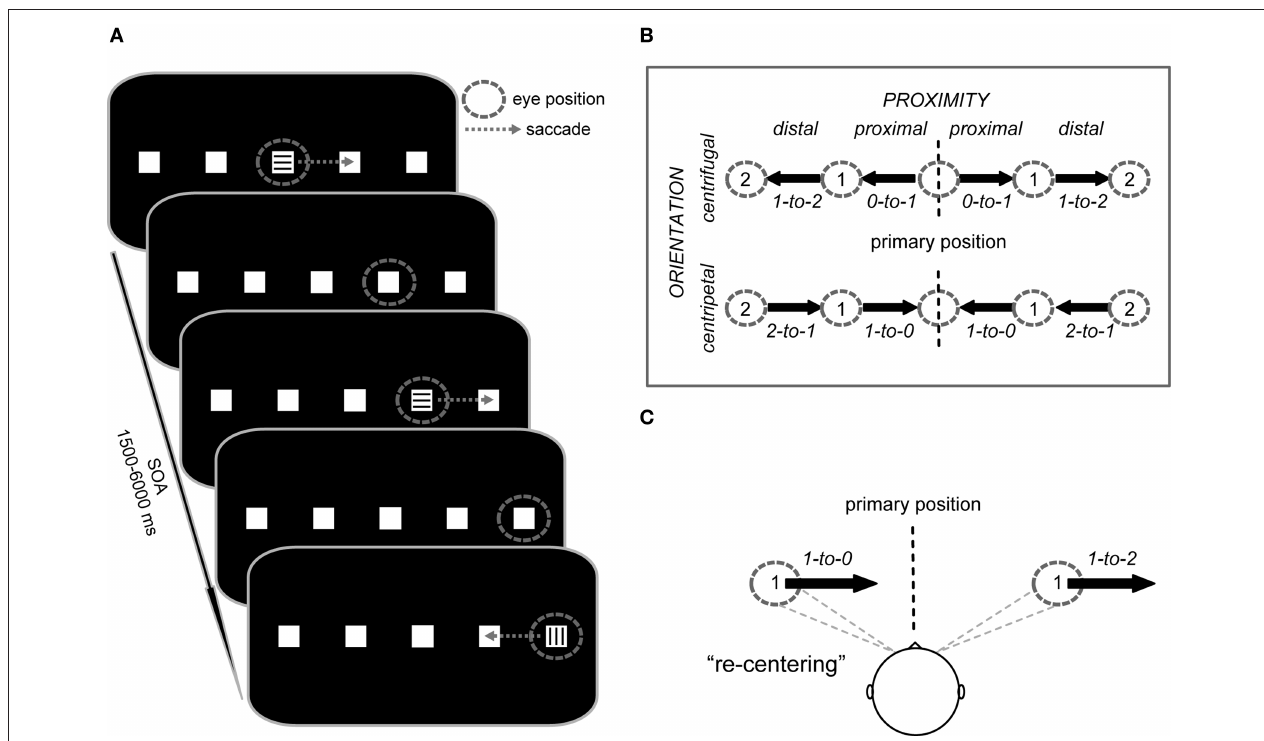
primary position (defined as head-centered straight gaze) and also differed in their proximity to the primary position (proximal vs. distal). The design thus resulted in four saccade trial types represented by vectors with specific start and end positions (start-to-end), i.e., proximal centrifugal (0-to-1) , distal centrifugal (1-to-2) , proximal centripetal (1-to-0) , and distal centripetal (2-to-1) , each of which could be performed to the left or right side. (C) Depending on